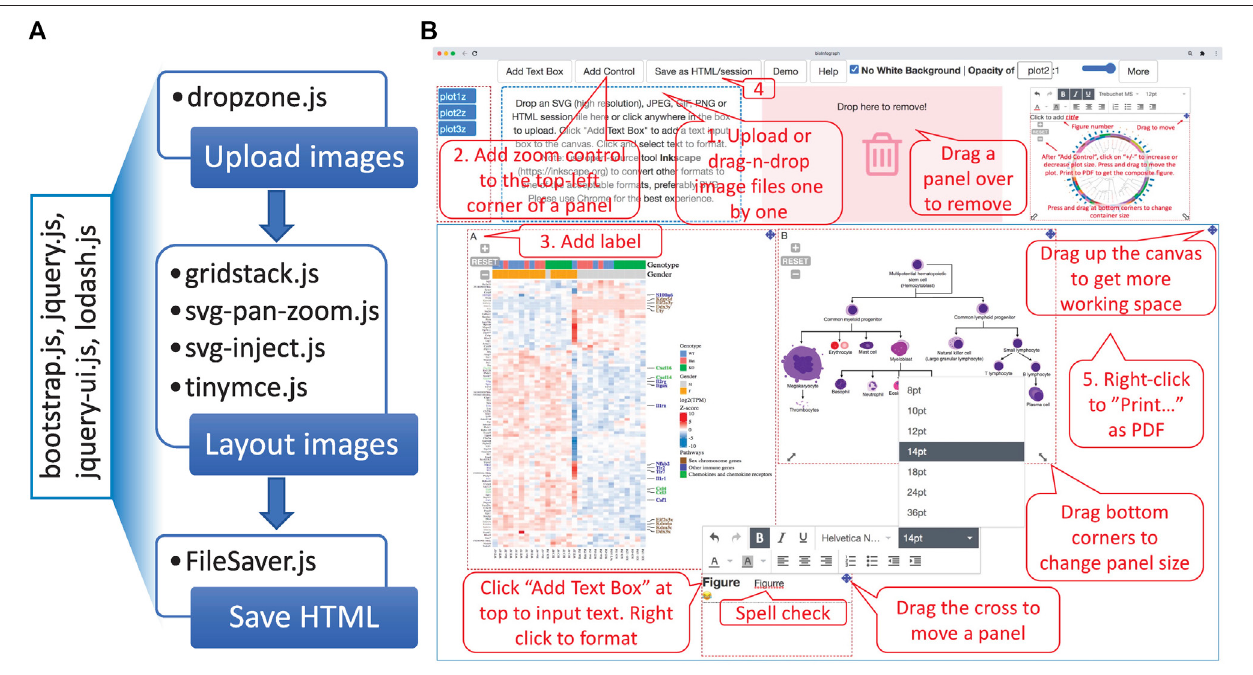
FIGURE3| Overviewofthesoftwarearchitecture andmainfeatures. (A) Theone-page webappispowered bygeneralJavaScriptlibrarieslistedintherotatedbox and speci fi c libraries used in each of three functional modules, “ Upload images, ” “ Layout images, ” and “ Save HTML. ” (B) BioInfograph allows users to easily arrange multiple plots in Scalable Vector Graphics (SVG), png, jpeg, or gif format exported by other tools. Each plot can be adjusted in size and placed freely on the canvas. A minimal work fl ow is outlined by numbered callout boxes in red, while important features not required by the minimal work fl ow are briefed in un-numbered boxes.